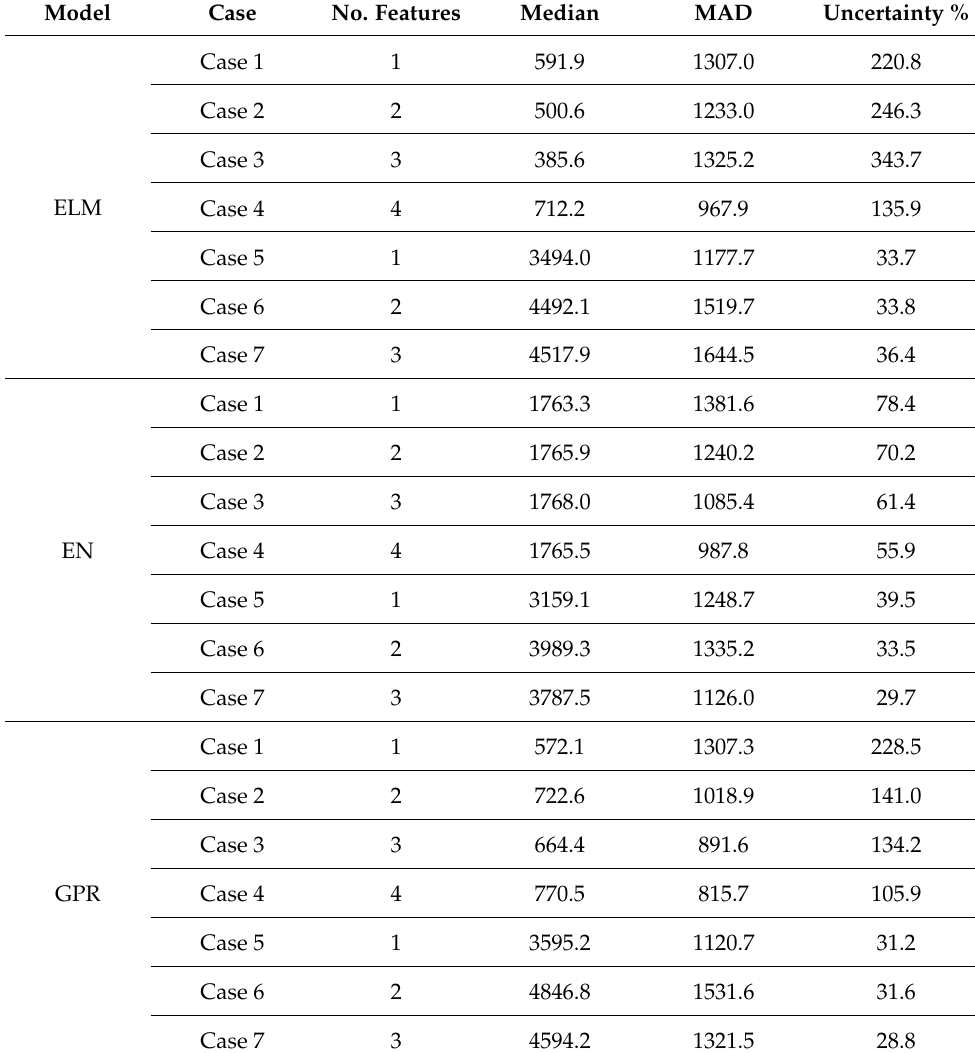
Table 15. Uncertainty analysis for the test set using Monte Carlo simulation (MCS). Model Case No.